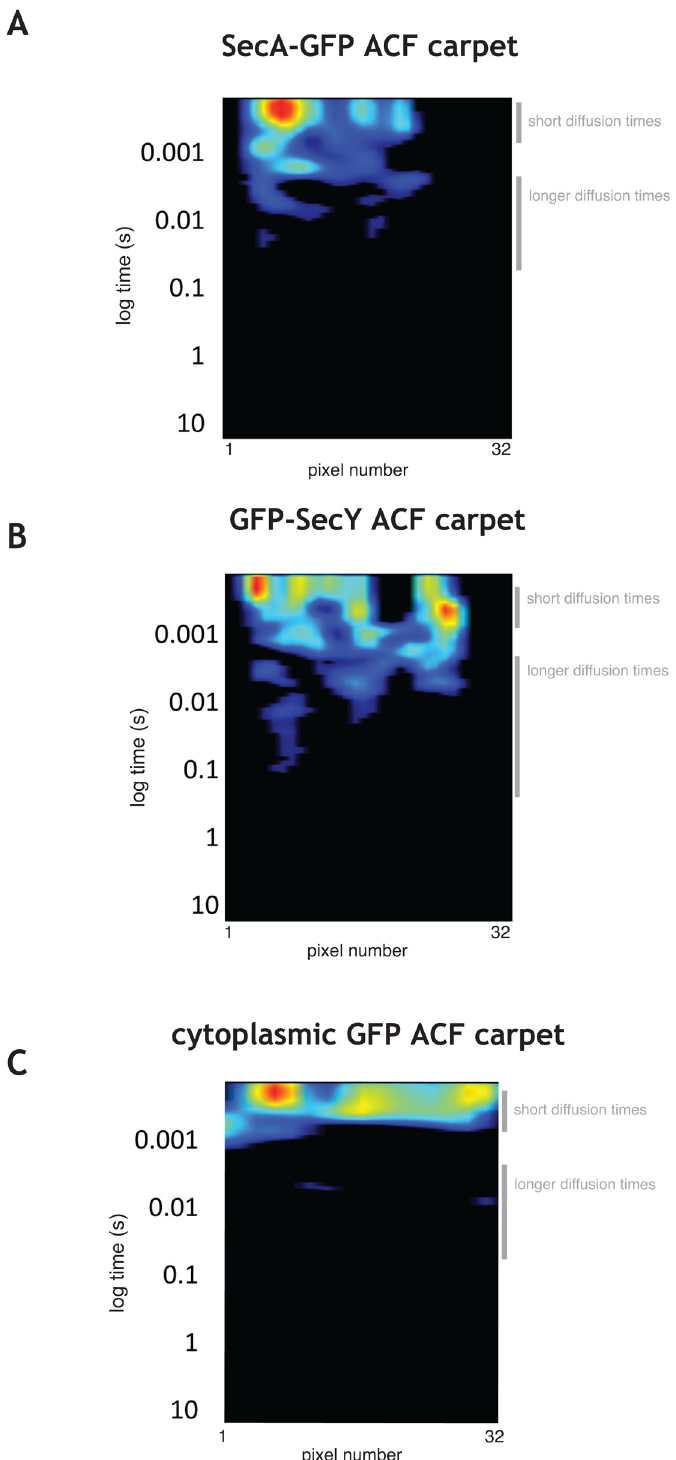
Fig 3. ACF analysis of SecA-GFP, GFP-SecY, and GFP. A, B, and C. Autocorrelation function (ACF) carpets for a typical exponentially growing B . subtilis cell expressing SecA-GFP (A) , GFP-SecY (strain amyE::pGY1) (B) , and cytoplasmic GFP (C). For all panels the amplitude of the autocorrelation function in each pixel is shown as a heat map (32 pixels, 80 nm each) plotted against a logarithmic time lag.